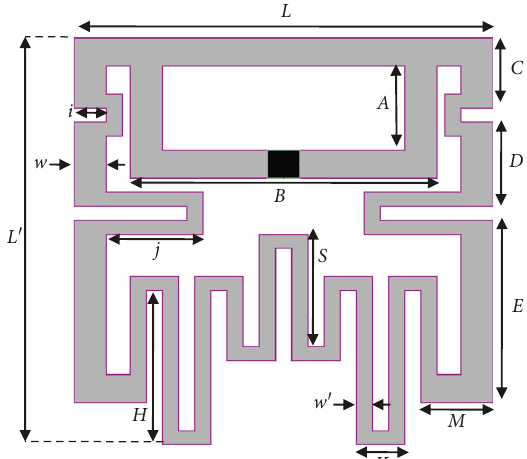
Figure 3: Geometrical layout of epidermal dual-loop tag with meandered lines in two